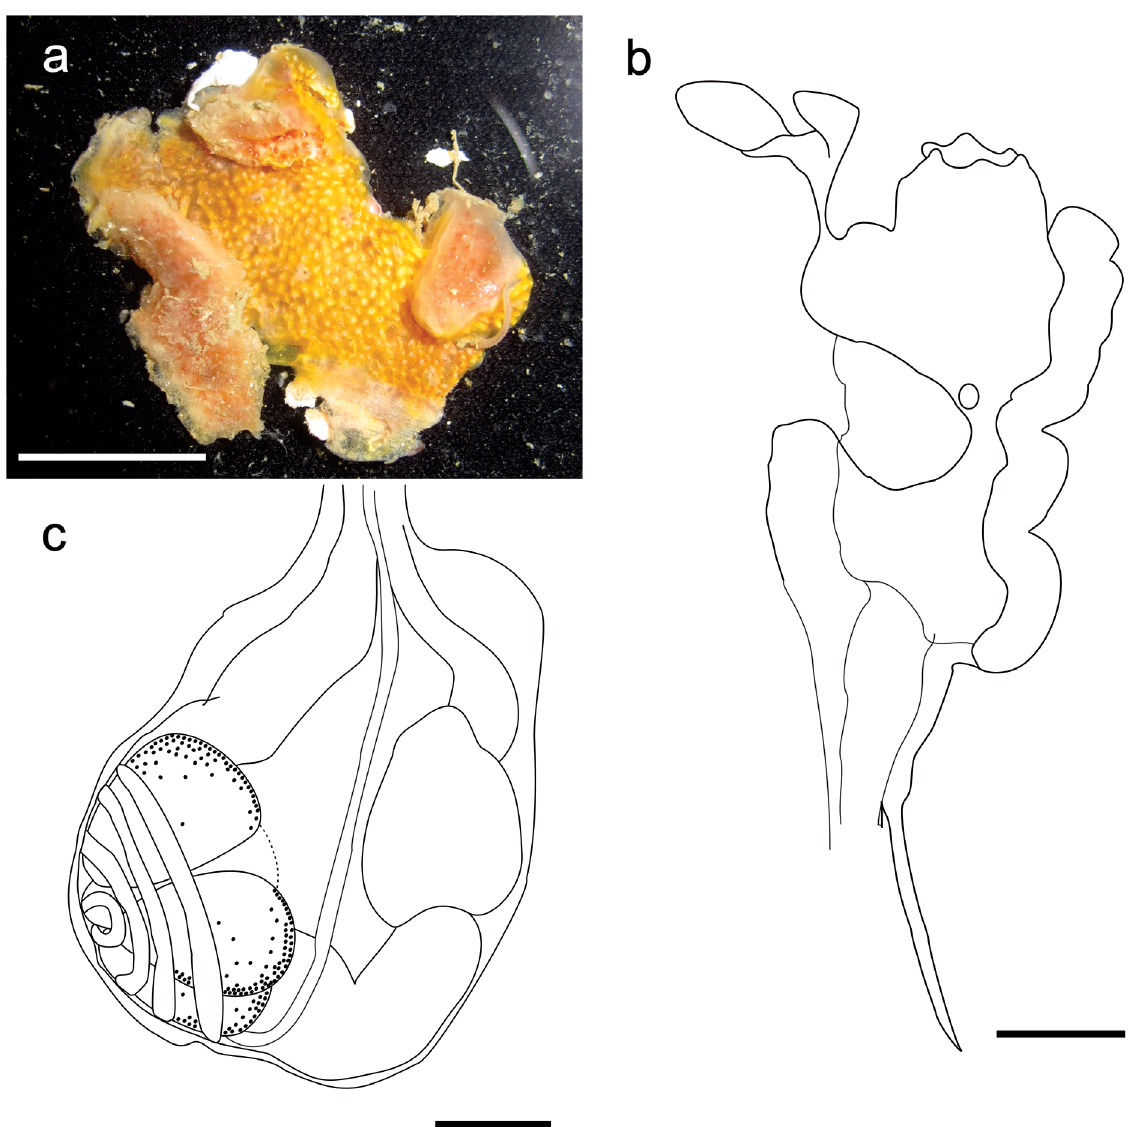
Fig. 12. Polysyncraton sp. a . Preserved colony. b . Thorax. c . Abdomen. Scale bars: a = 1 cm; b–c = 0.1